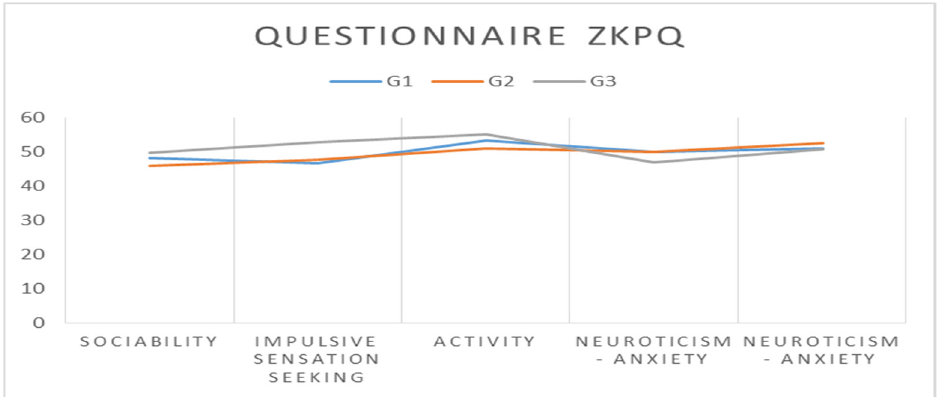
Figure 2. Representation of the arithmetic means recorded by the three groups for each ZKPQ subscale. Table 7. Statistical analysis of the data of the Personal Autonomy Questionnaire